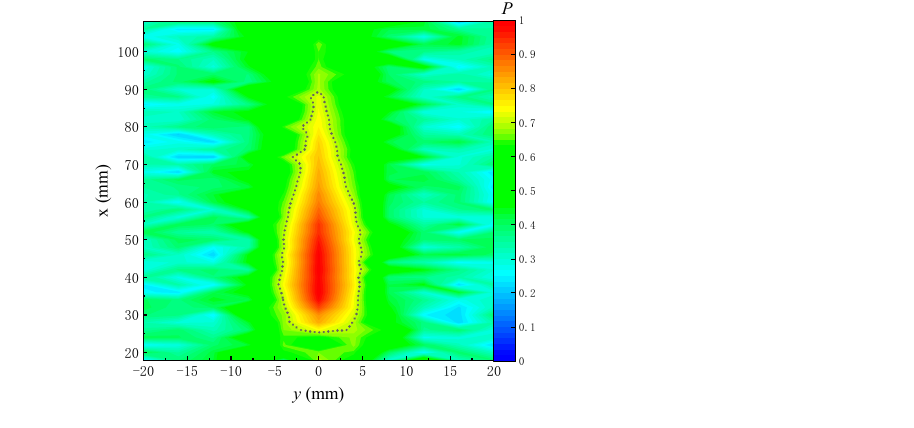
Figure 5. Spatial distribution of the radiated acoustic field perpendicular to the radiation surface of the ultrasonic transducer.